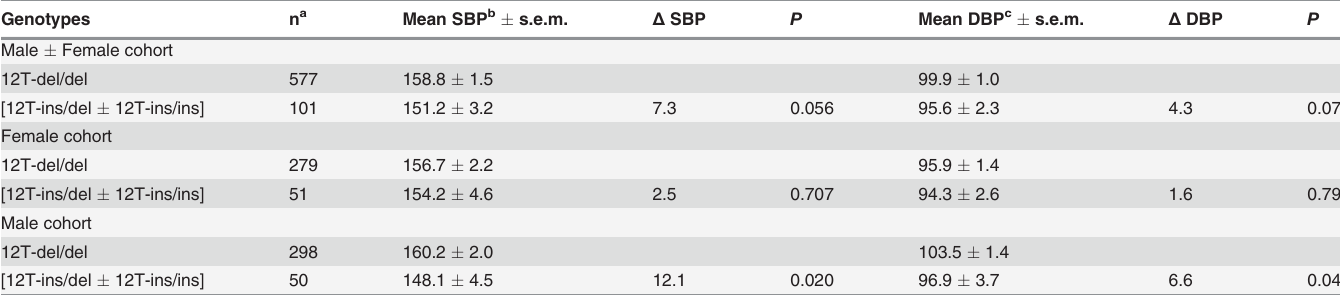
Blood pressures were adjusted for age, body mass index and case/control status.